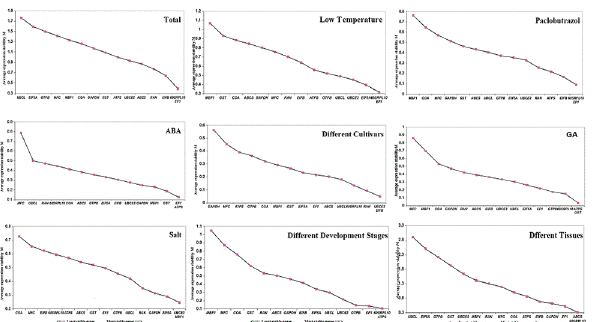
Fig 4. Gene expression stability values (M) of the candidate RGs calculated by geNorm. The figure shows the ranking of the gene expression stability performed in ABA stress, GA 3 stress, paclobutrazol stress, cold stress, different cultivars, different development stages, and total samples. The most stable genes are on the right, and the least stable genes are on the left. GA 3 : gibberellin acid. ABA: abscisic